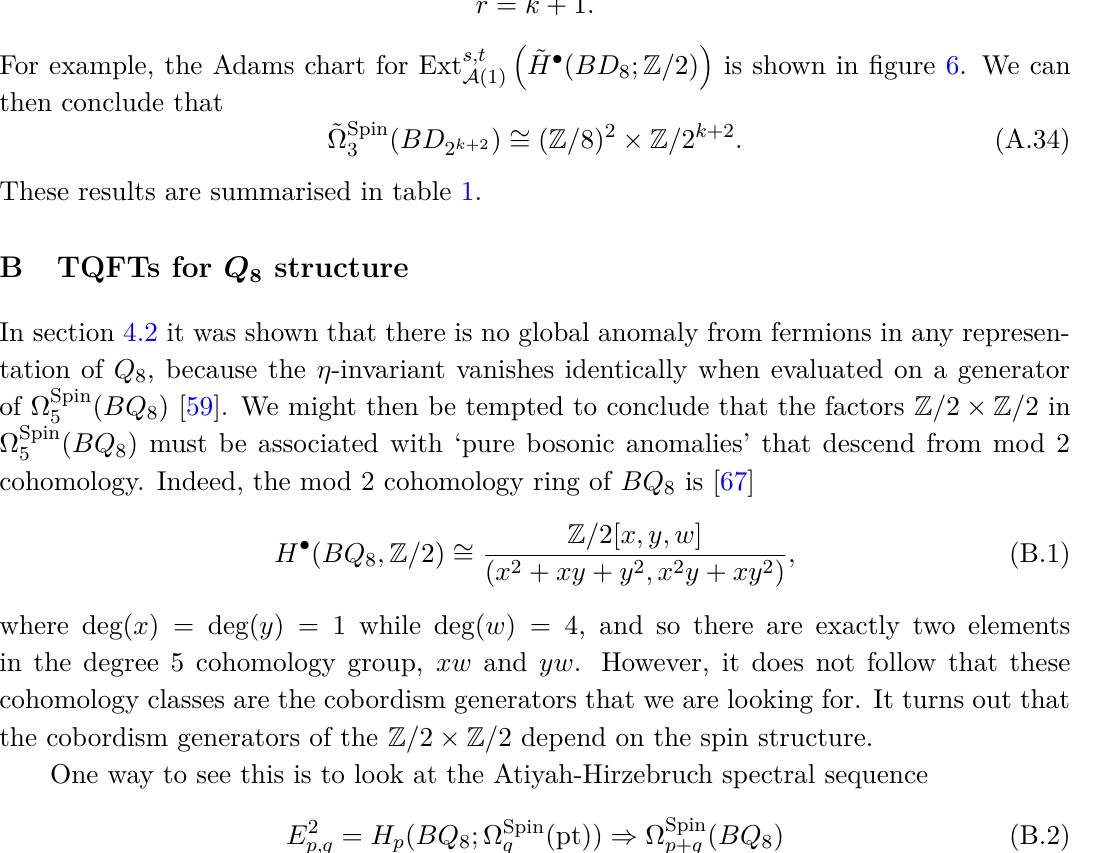
(cid:0) ˜ H • ( BD 8 ; Z / 2) , Z / 2 A (1)